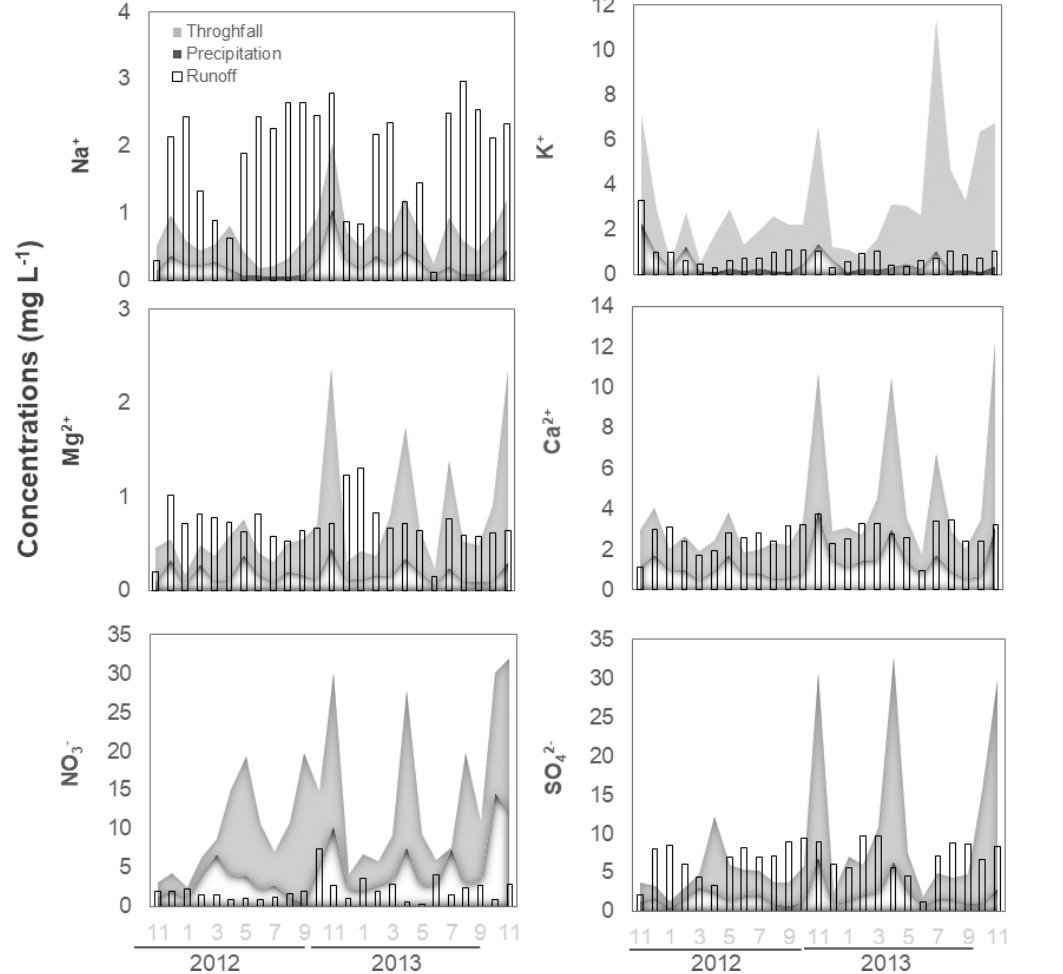
Figure 2. Hydrochemical data relevant for the monitoring period (2012–2013). The x axis shows months and hydrological year; concentra- tions following Oulehle et al.